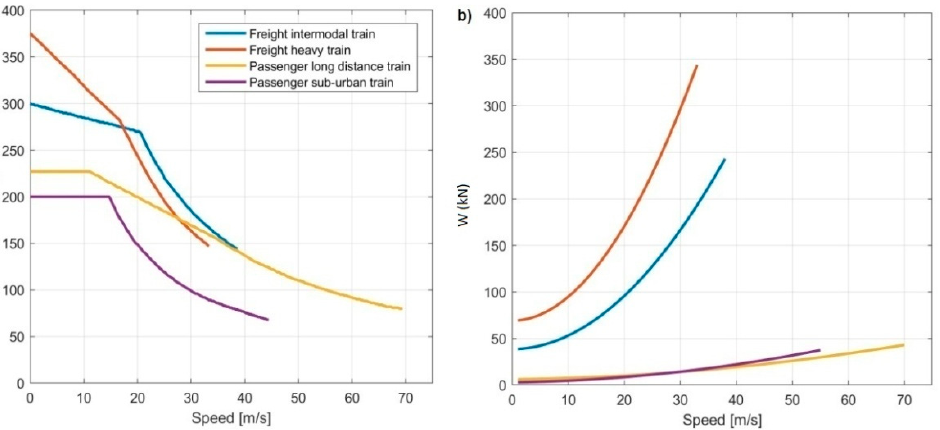
Figure 5. The traction characteristics and rolling resistances of the assumed in the case study rolling stock.